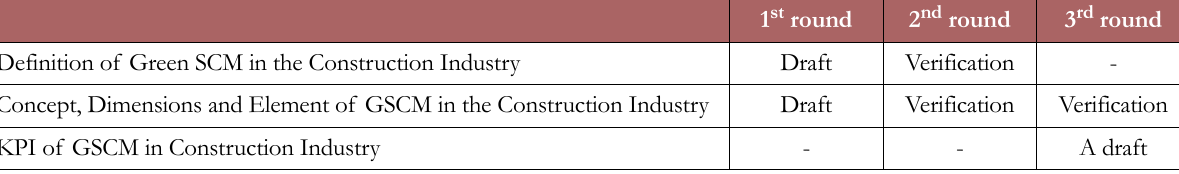
Table 3. Steps of the Delphi Method in this Research